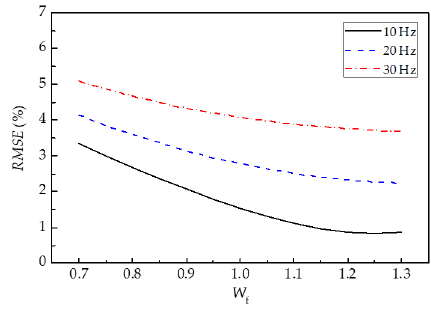
Figure 6. RMSEs for different situations.